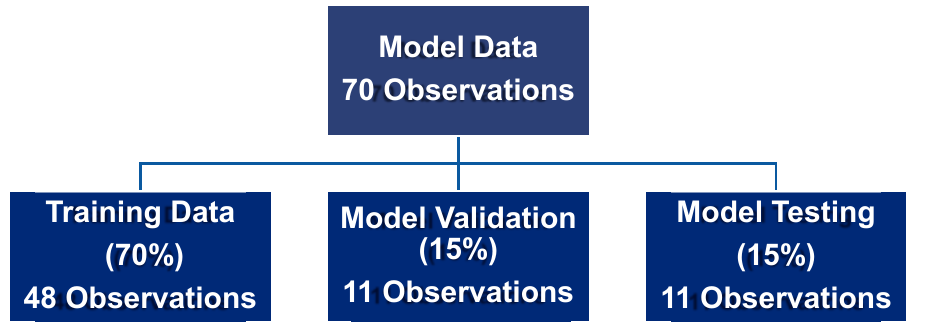
Figure 4. Flow Chart for use of data for Training, Validation, and Testing.